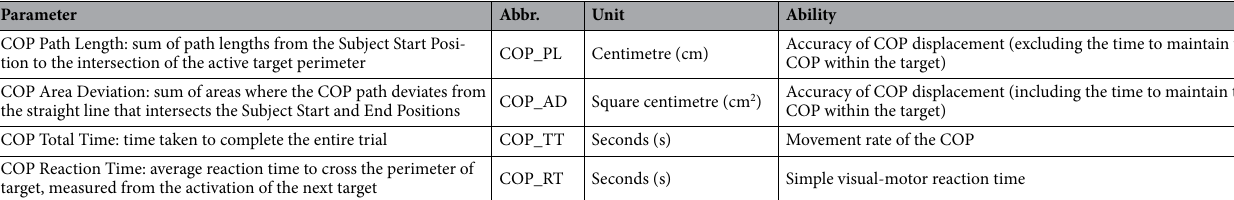
Table 1. Description of the characteristics analysed with abbreviations, units, and abilities under